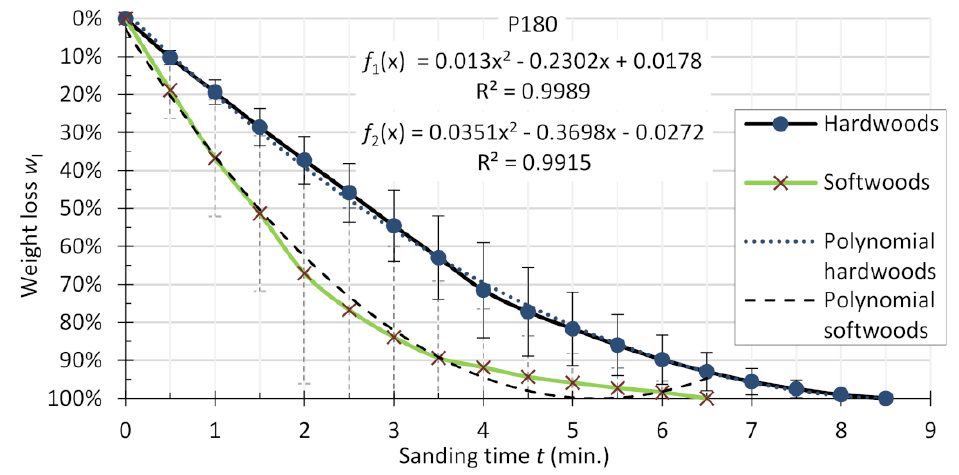
Figure 11. Comparison of average results for hardwoods (beech, oak, ash, hornbeam, alder) and softwoods (pine, spruce, larch) species; P180